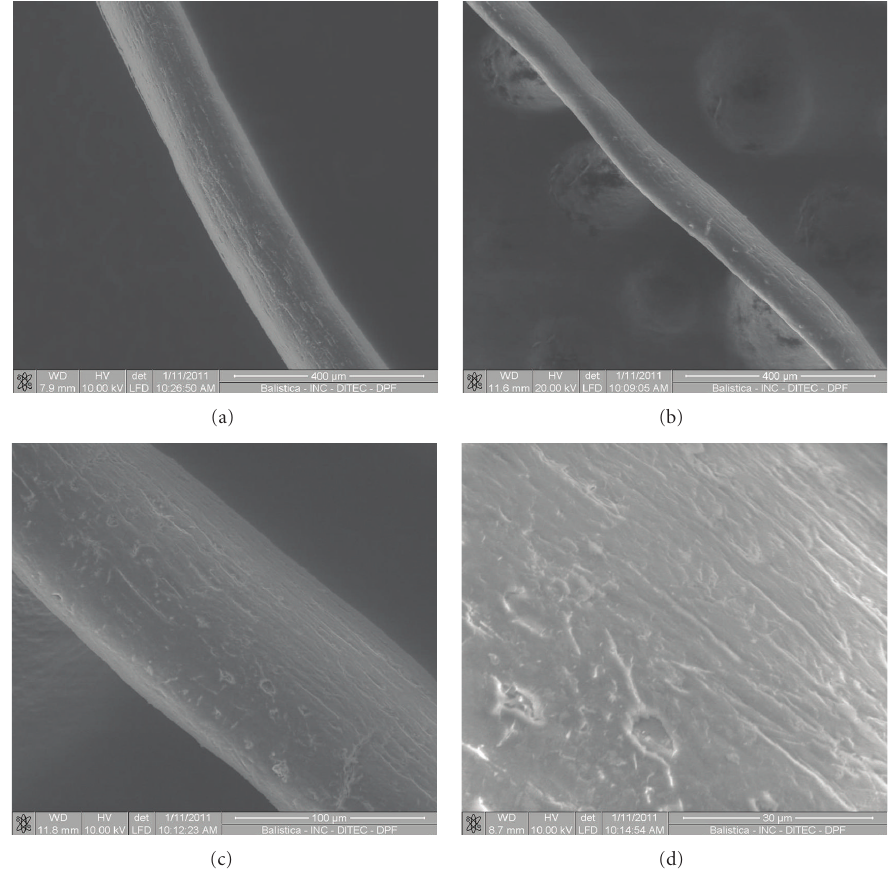
Figure 3: SEM photomicrographs (400 μ m) of untreated (a) and NaOH-treated (400, 100, and 30 μ m) coir fibre surfaces (b–d).